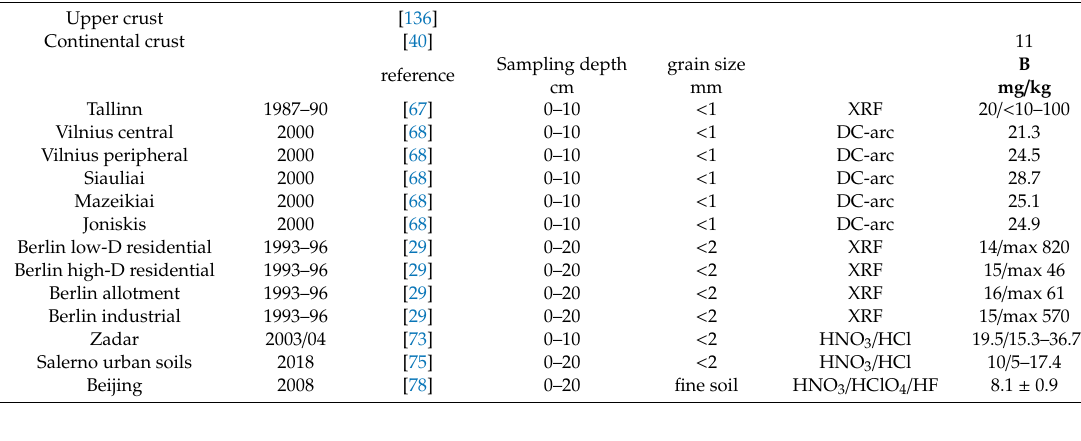
Table A5. Silver in urban soils.